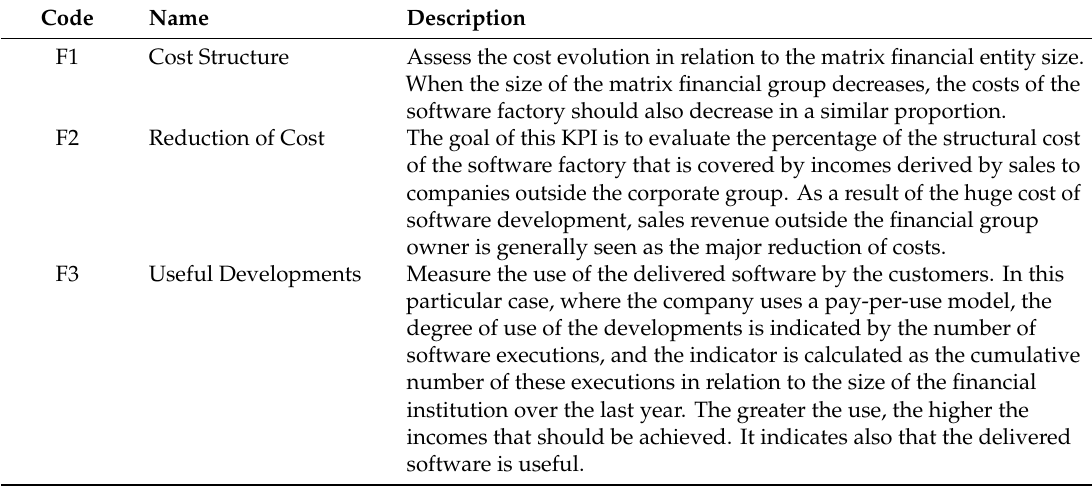
Table 1. Summary of the financial perspective key performance indicators (KPIs).